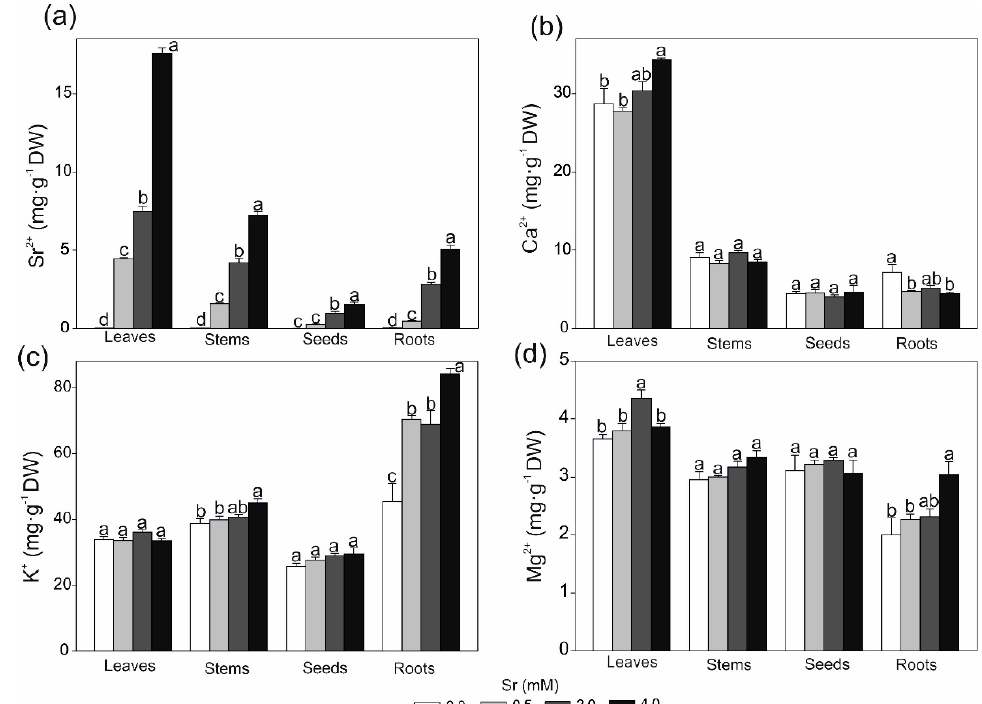
Figure 3. Effect of various strontium concentrations on the content of ( a ) strontium; ( b ) calcium; ( c ) potassium; and ( d ) magnesium in different soybean organs. Data are means ± SE ( n = 4). Values followed by the same letters within the same plants’ organs are not significantly different ( p < 0.05, Tukey’s test)